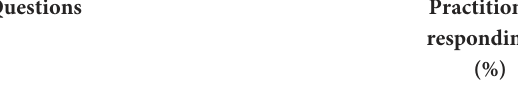
TABLE 2 Practitioners’ knowledge of pregnancy management in